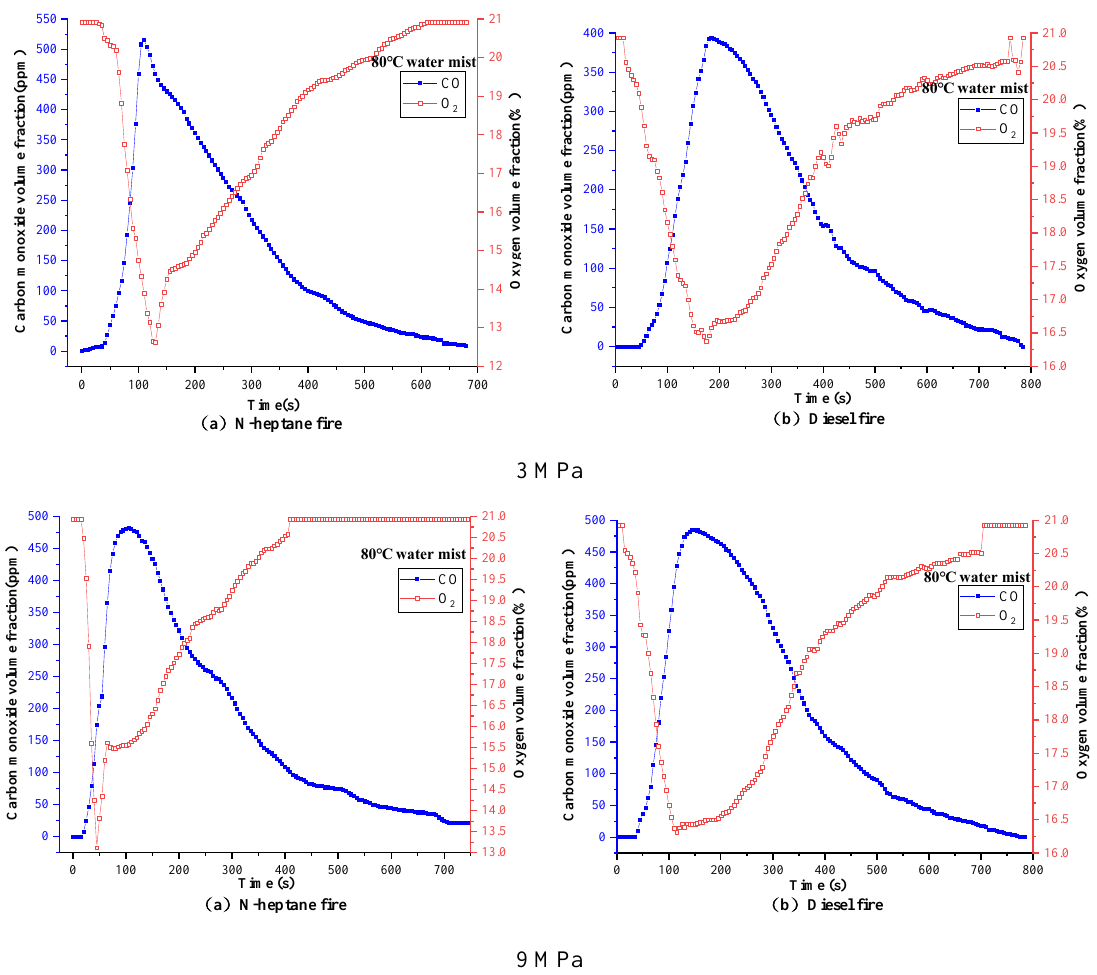
Figure 9. Change diagram of flue gas composition of diesel and n-heptane under the action of hot water mist at 3 MPa and 9 MPa.